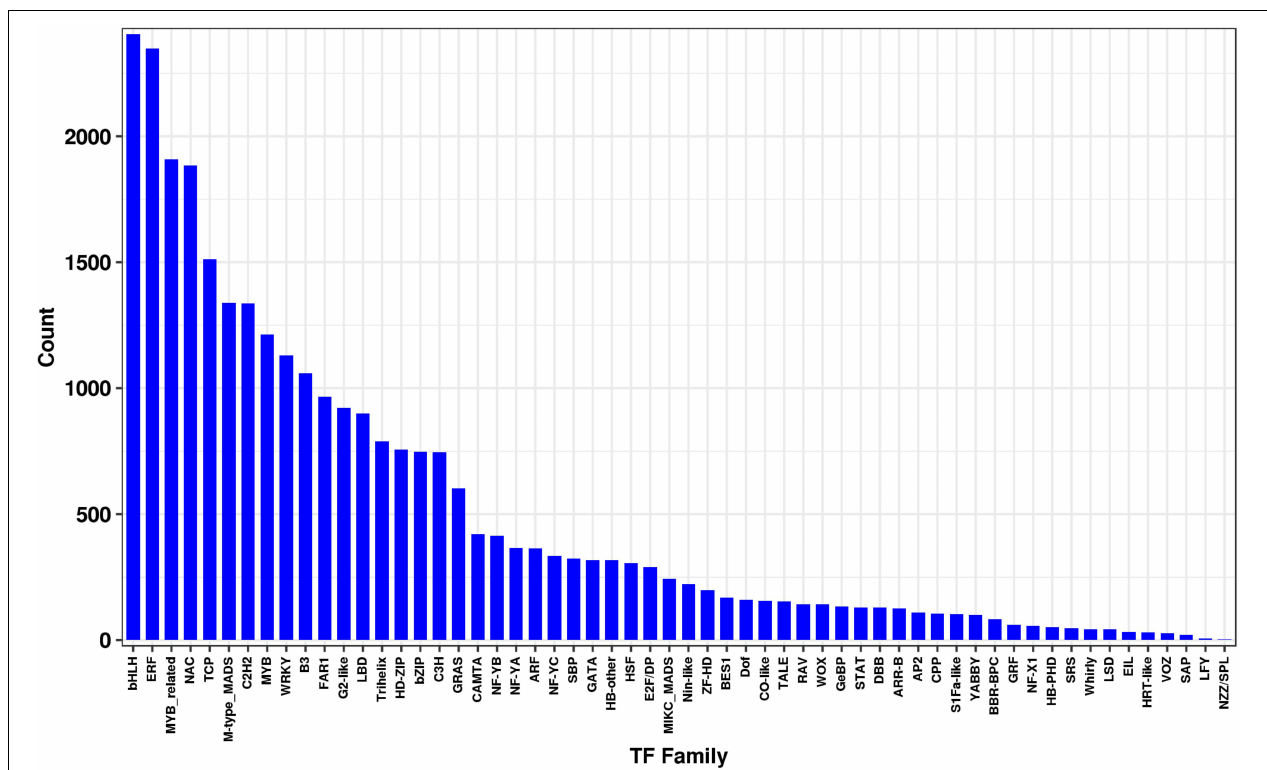
FIGURE 5 | Transcription factors (TF) analysis from the L. longituba transcriptome data ( N =